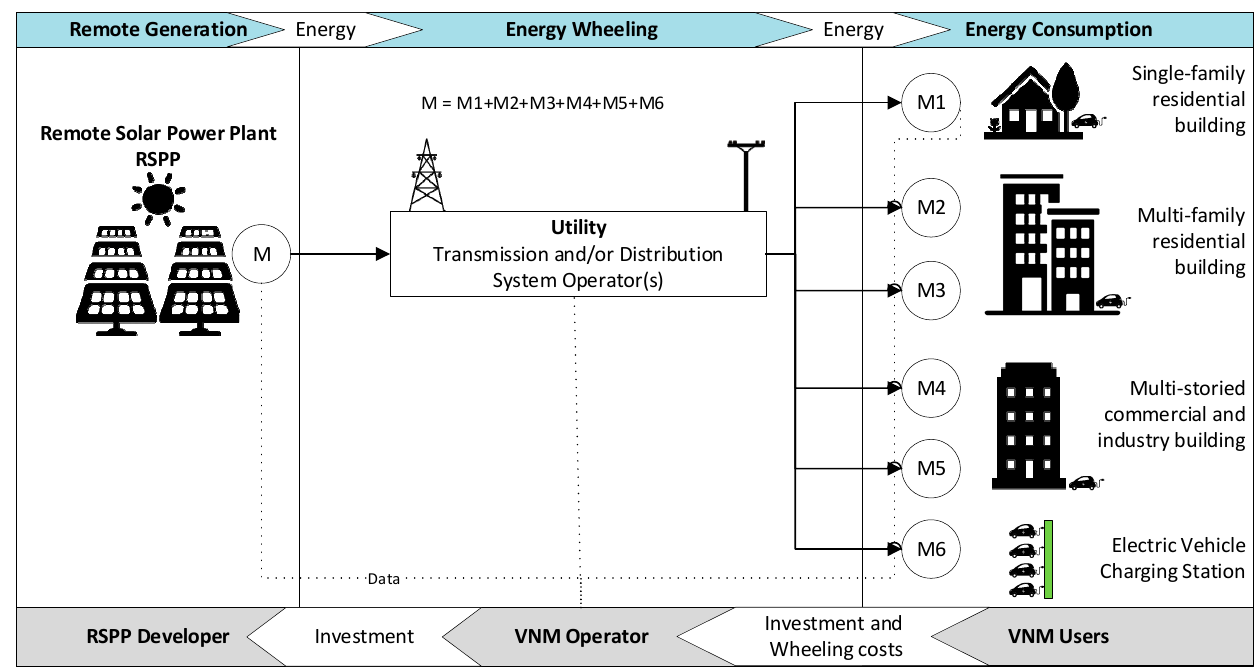
Figure 2. Concept of virtual net-metering. Energy is generated in a remote solar power plant that is owned by a group of consumers. Then the energy is transported via utility grids to those consumers. VNM users share investment and operation costs and pay wheeling charges. An independent VNM operator aggregates the meter, and the RSPP developer develops solar power plants. (illustration by author).